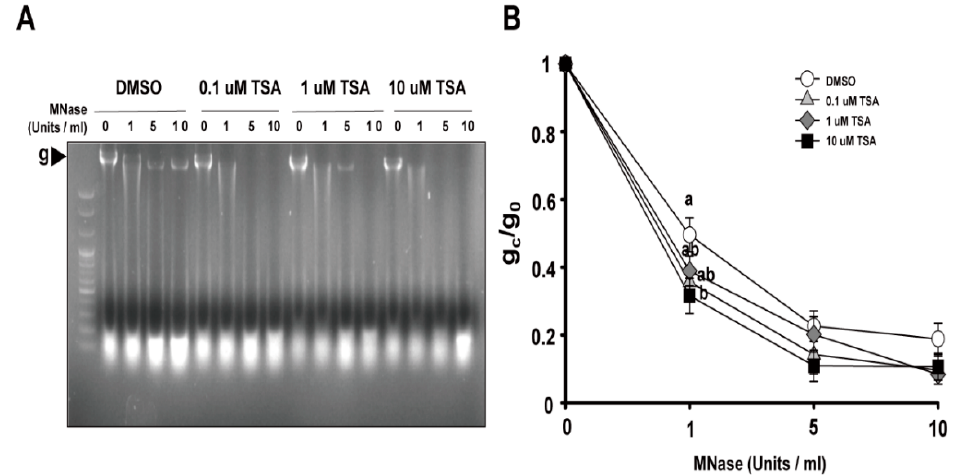
Figure 4. The effect of TSA on chromatin structures in lettuce protoplasts. ( A ) Representative image of chromatin digestion with micrococcal nuclease (MNase). The genomic band intensities with different concentrations of TSA were examined. The arrow means the genomic band without and with treatment with different concentrations of MNase. ( B ) Proportion of MNase-digested chromatin DNA resolved on agarose gels. The genomic band intensities without (g 0 ) and with (g c ) treatment with different concentrations of MNase were quantified, and the ratio of g c /g 0 was used to represent the degree of chromatin relaxation. Bars represent means ± SE ( n = 5) of independent experiments. Different letters on the bars indicate significant differences between each treatment (ANOVA with Duncan’s test, p < 0.05).